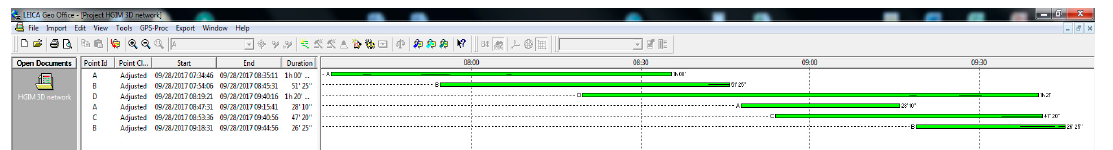
Figure 3. GNSS network.